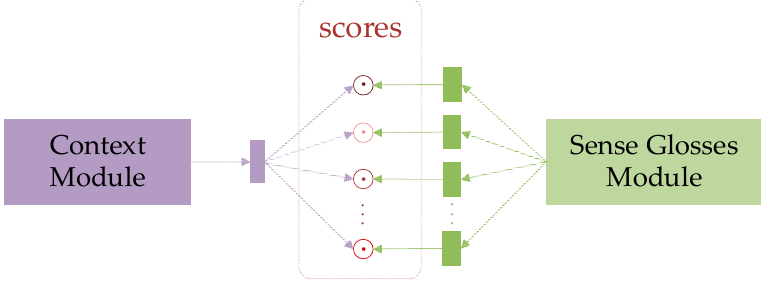
Figure 1. Overview architecture of BiCapAtt.